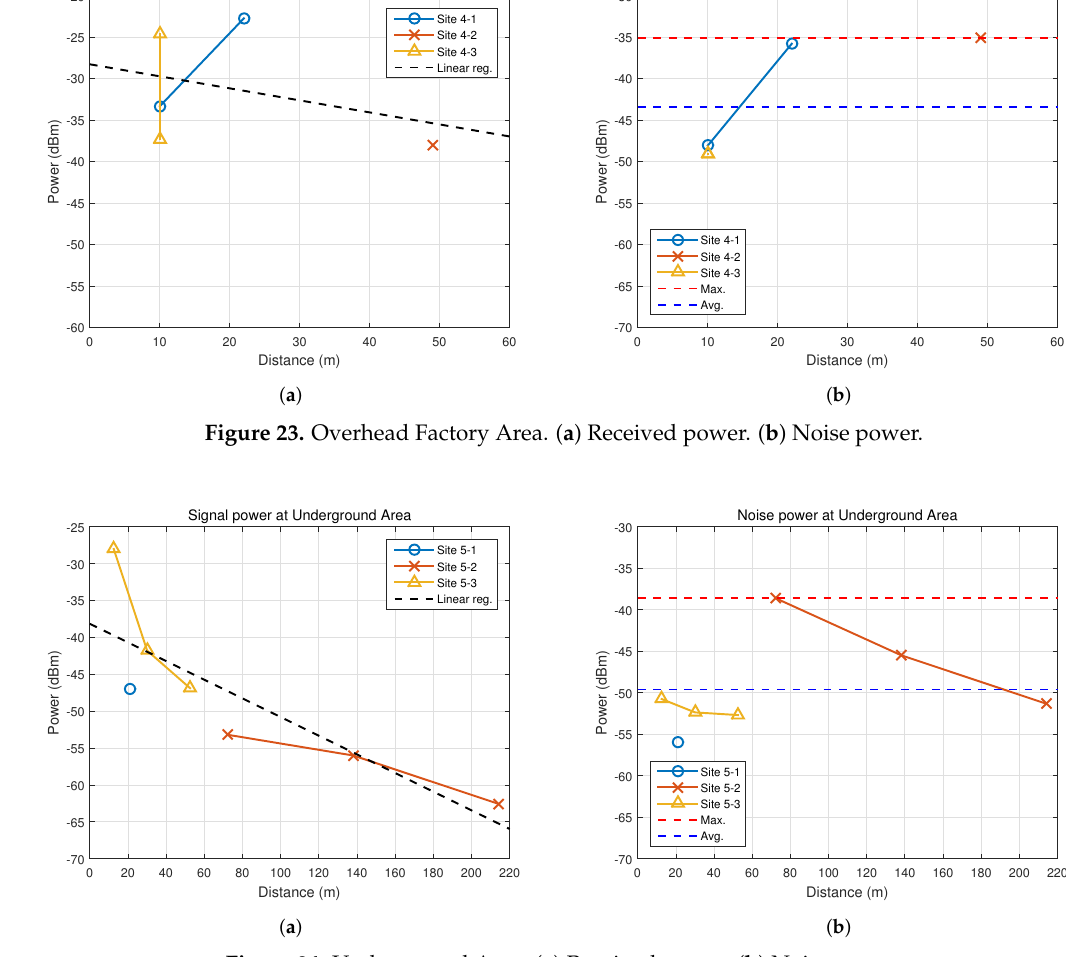
Figure 24. Underground Area. ( a ) Received power. ( b ) Noise